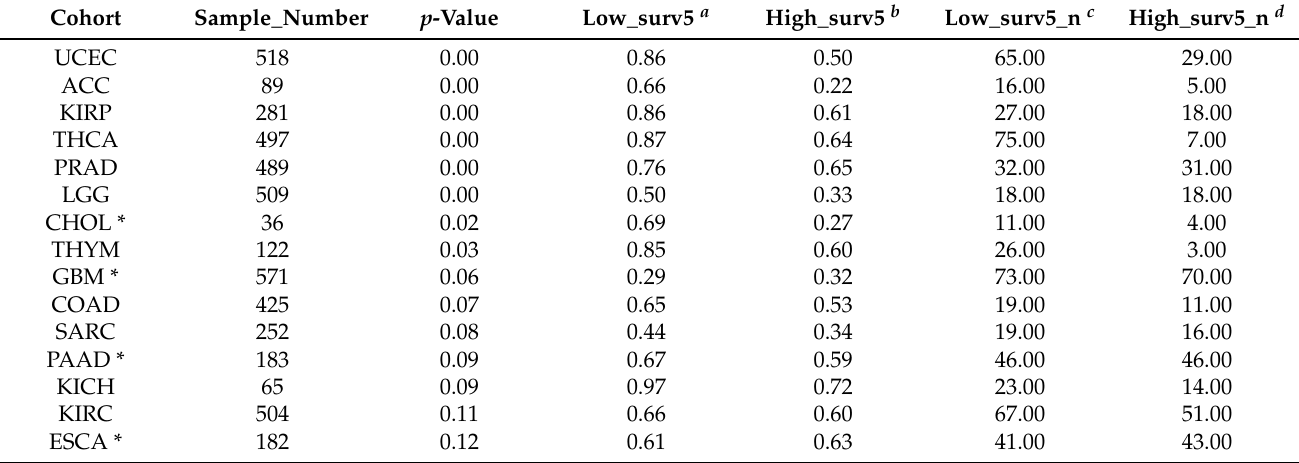
Table A6. Association between S-CIN and progression-free survival across cancer